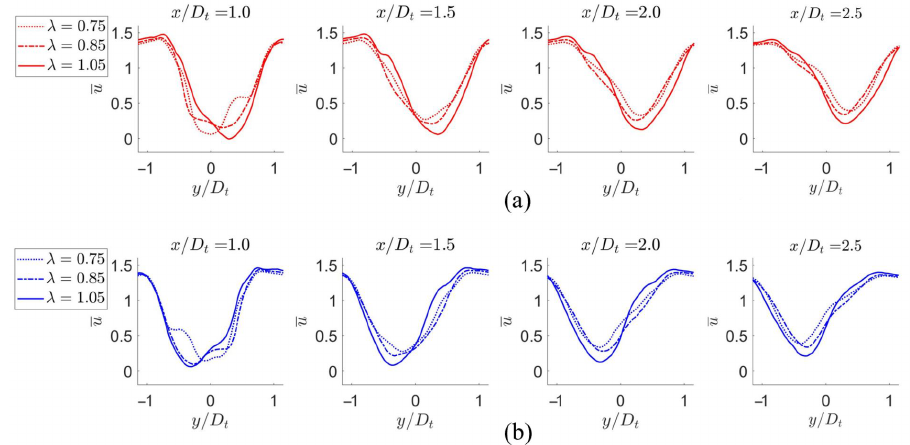
Figure 13. The streamwsie velocity component of turbine T1 ( a ) and T2 ( b ) at the 3 tip–speed ratios and 4 streamwise